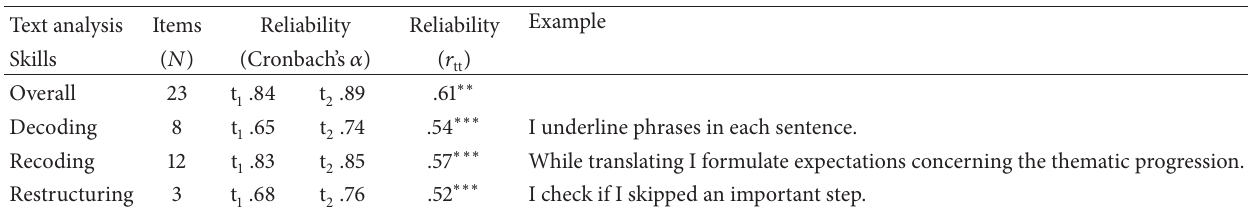
Table 3: Summary of reliability estimates for general text analysis skills, on the overall scale and on the scales decoding, recoding, and